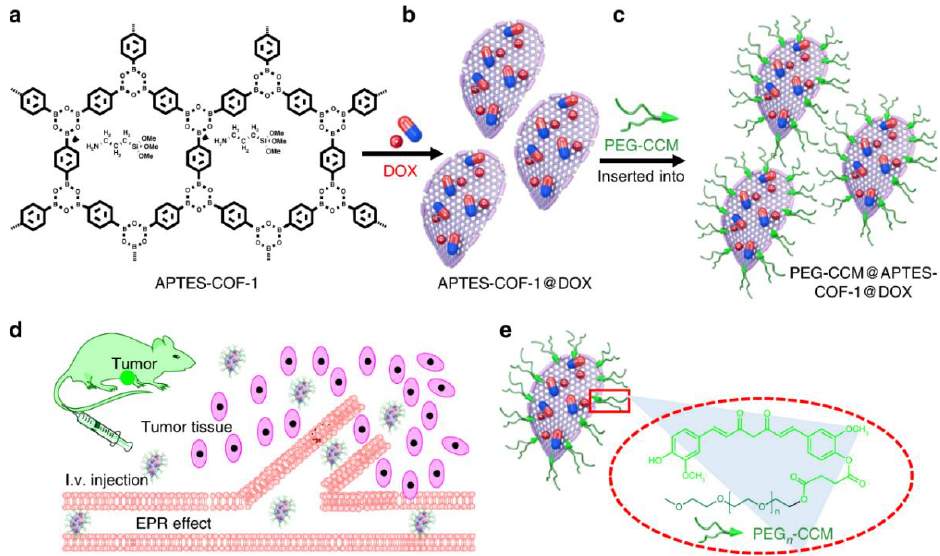
Figure 9. Synthesis of DOX-loaded PEG-CCM@APTES-COF-1 with cellular uptake at weak acidic tumor tissue/cells ( a – d ). ( e ) Synthesis of PEG-CCM amphiphilic block copolymers containing hydrophobic blocks based on the unplugging of the PEG-CCM polymer from the APTES-COF-1 pores [108]. Reprinted with permission from ref. [108]. Copyright 2018 Springer Nature.